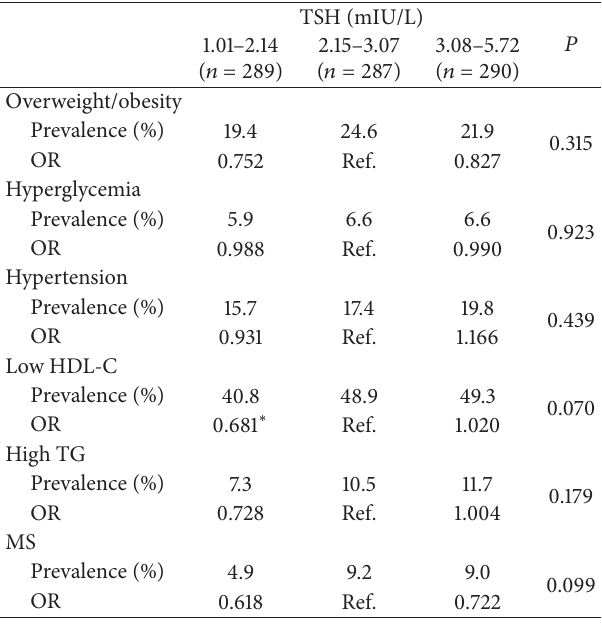
Table 5: Comparison of the prevalence of metabolic syndrome and its components in groups with normal TSH levels.